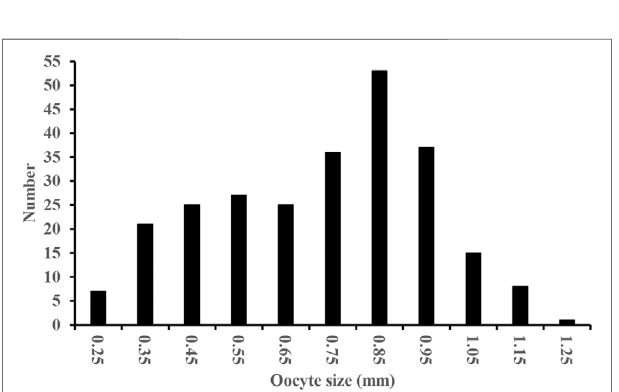
FIGURE 7 | Oocyte size-frequency distribution in a randomly chosen S. curriculus specimen with stage IV gonads (period: July, SL (cid:1) 252 mm, weight (cid:1) 379.03 g, No. of eggs (cid:1) 255).